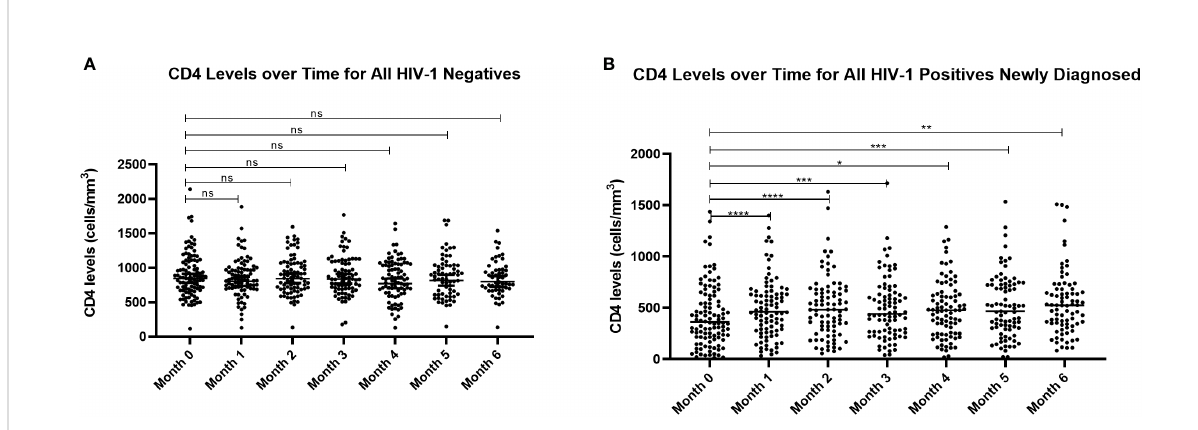
FIGURE 6 Comparison of CD4+ T cell counts for (A) HIV-1 negative volunteers and (B) HIV-1 positive newly diagnosed volunteers over time. Analysis by mixed model ANOVA with Dunnett ’ s multiple comparison test showed signi fi cant differences in CD4+ T cell counts for HIV-1 positive volunteers over time relative to month 0 (**** p <0.0001, *** p <0.0005, ** p <0.005, * p <0.05). There were no differences for the HIV-1 negative group. ns means not signi fi